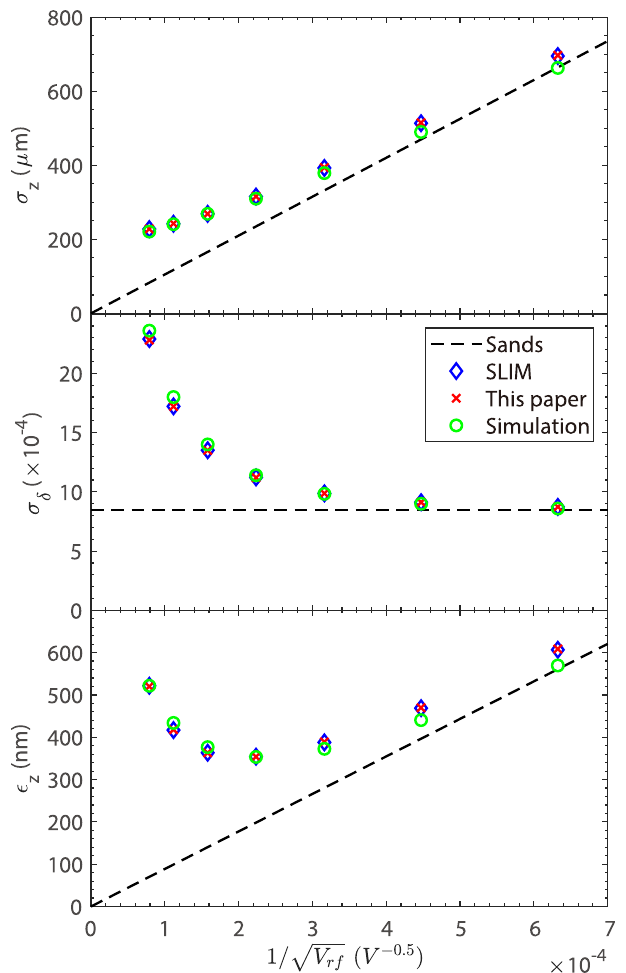
FIG. 2. Bunch length saturation and energy spread and longi- tudinal emittance divergencewhenthe bunchlengthispushedtothe limitgivenbyquantumdiffusion,inthesimulationbyincreasingthe rf voltage. The lattice optics and related parameters are shown in Fig. 1 and Table I. In each simulation, 1000 electrons are tracked for 50000 turns, which corresponds to about five longitudinal damping times, and the averaged result of the last 10000 turns are used to get the σ z , σ δ , and ϵ z . The observation point is at the rf.